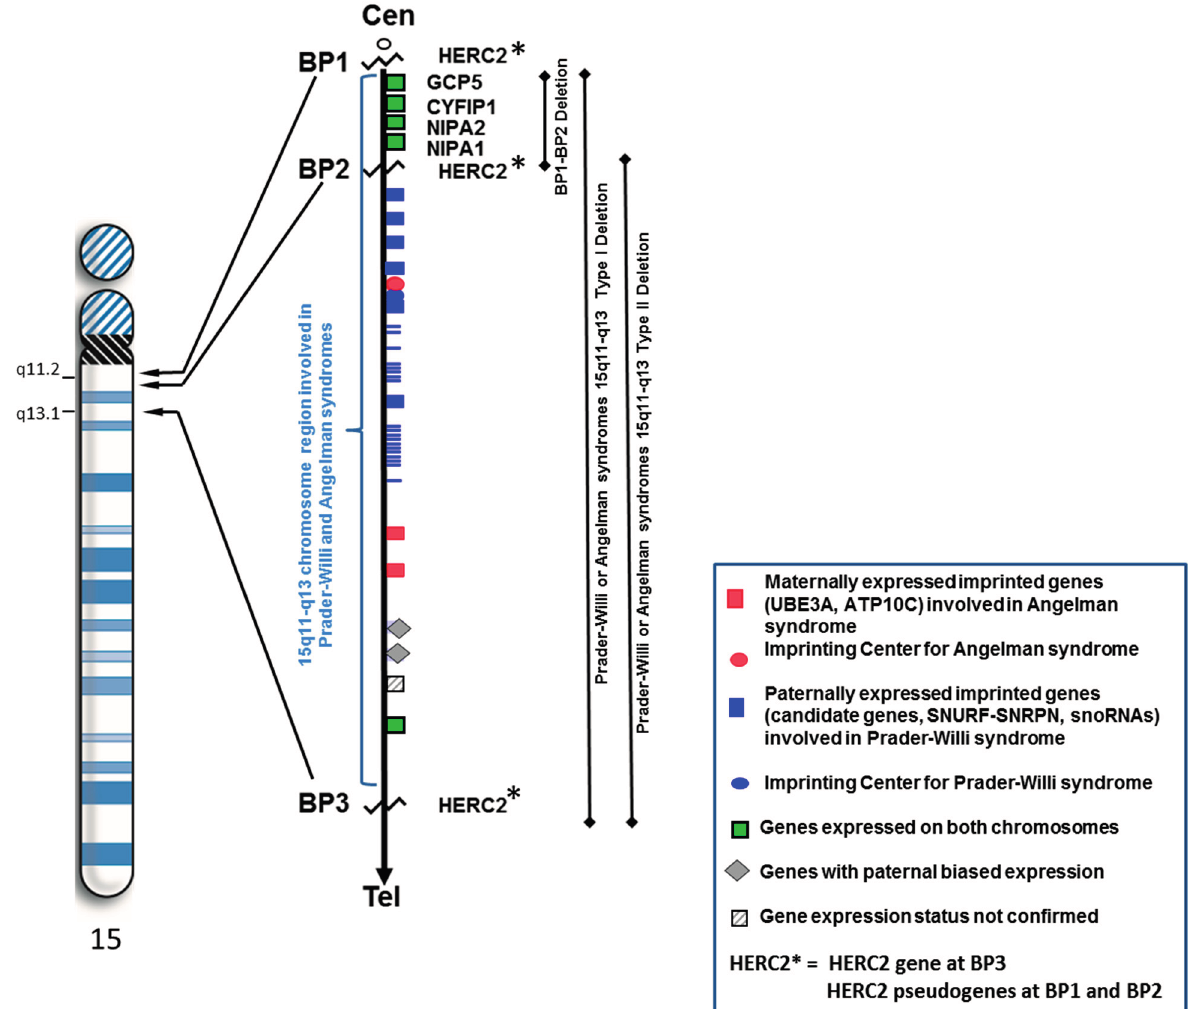
Figure 1. High resolution ideogram representing chromosome 15 showing location of breakpoints BP1 and BP2 (at 15q11.2 band) and BP3 (at 15q13.1 band) involving HERC2 and position of the non-imprinted genes between BP1 and BP2. The three deletion